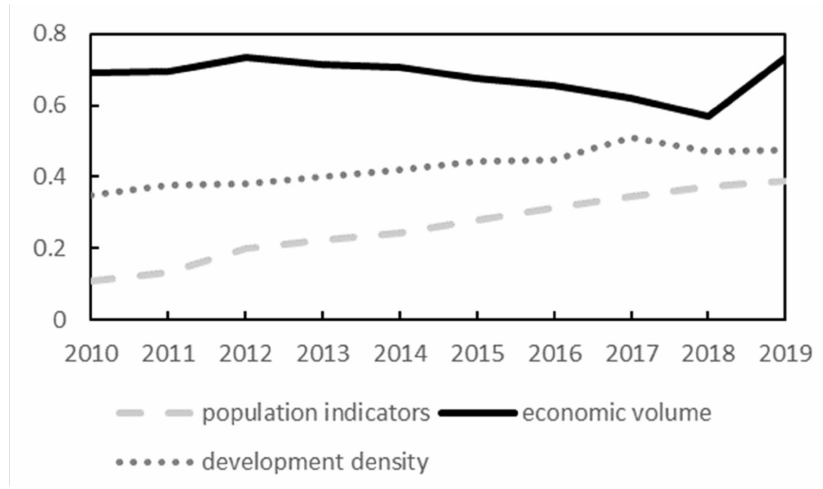
Figure 2. Trend of the economic development index in the Yellow River basin (data obtained by averaging three standardized